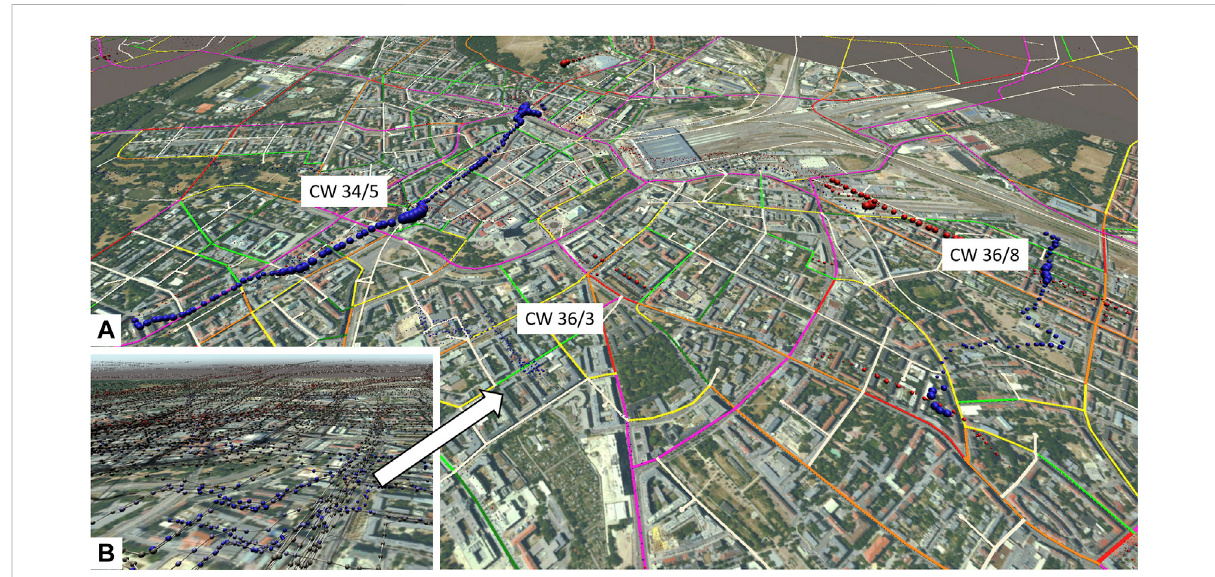
FIGURE 11 Identi fi cation ofoutliers, e.g., cold spots ofNO concentrationfor three participants usingrepresentation ofvaluebycolour and size (inaddition simulated traf fi c is shown as lines). (A) with size by value and (B) without size by